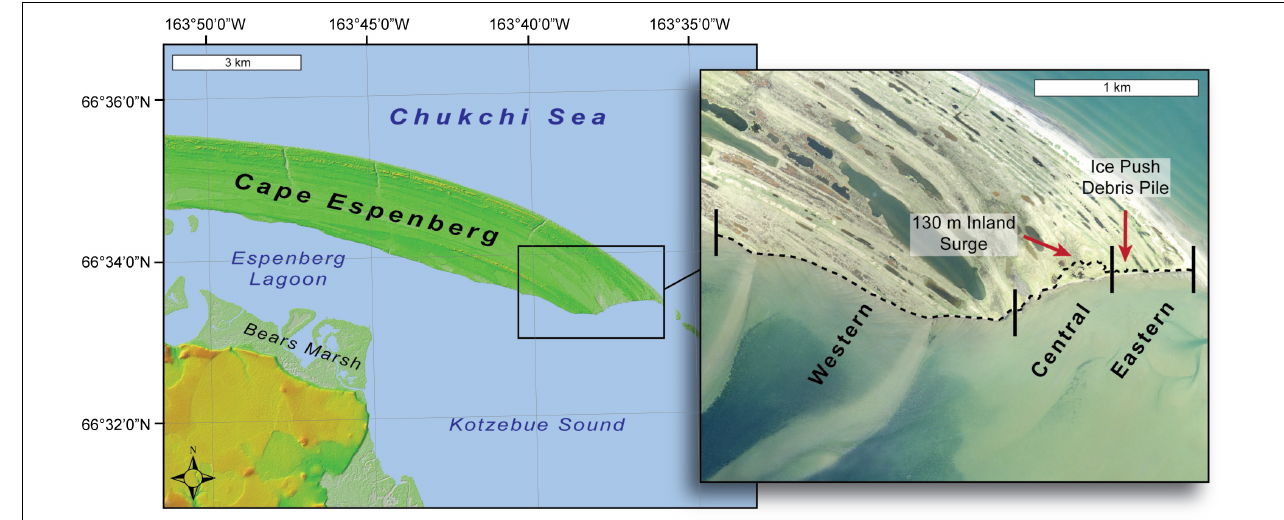
FIGURE 3 | Map showing the area impacted by the 2017 Cape Espenberg ivu. The map on the left uses elevation data from the ArcticDEM, created by the Polar Geospatial Center from DigitalGlobe, Inc., imagery (Porter et al., 2018). The insert map on the right shows the surveyed, spatial extent of the impacted coastline (dashed line) and denotes the Eastern, Central, and Western sections discussed in the text with vertical black lines. The 1,000 m 3 ice-push debris pile that impacted cultural resources and the maximum inland extent of the storm surge is marked with the red